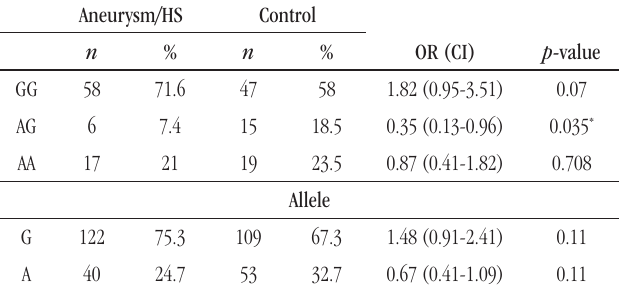
taBLE 2 − Association of TNFA -308G/A (rs1800629) polymorphism with HS or aneurysm